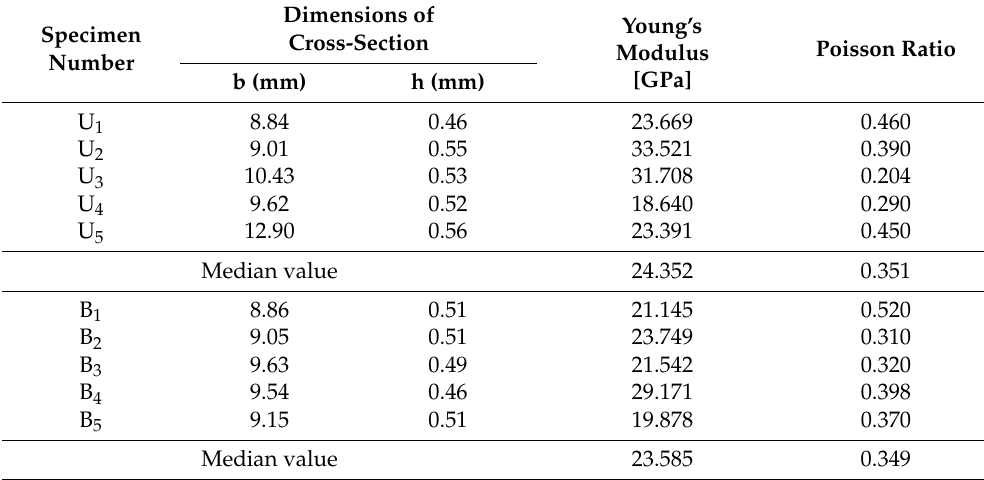
Table 2. Mechanical characteristics of the single-ply test